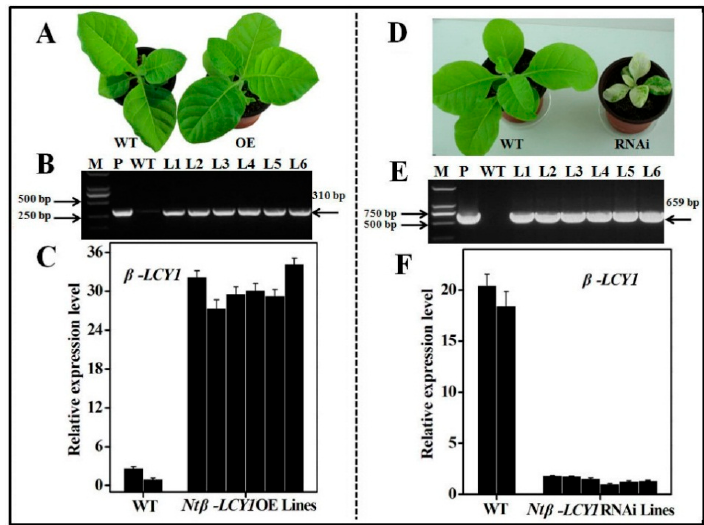
Figure 4. Identification and characterization of expression of the transgenic Nt β -LCY1 overexpression (OE) and RNAi plants by PCR and qRT-PCR. ( A ) Phenotypes of WT and Nt β -LCY1 OE transgenic tobacco; ( B ) Confirmation of the presence of the Nt β -LCY1 transgene construct in the OE transgenic plants based on PCR screening using primers flanking the Nt β -LCY1 gene. Lane 1: Marker DL2000; Lane 2: positive control; Lane 3: negative control. Lanes 4–9 are six independently Nt β -LCY1 OE